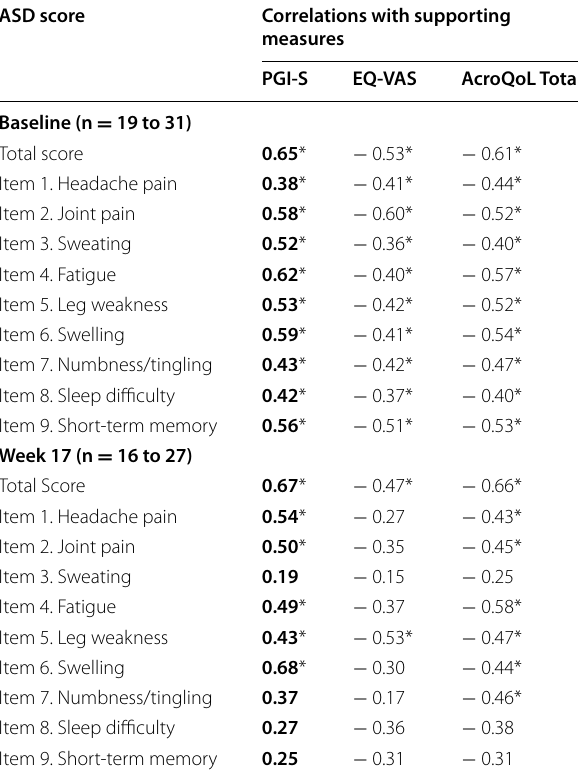
Table 6 Construct validity correlations of ASD total scores Table 7 Responsiveness correlations of the ASD weekly